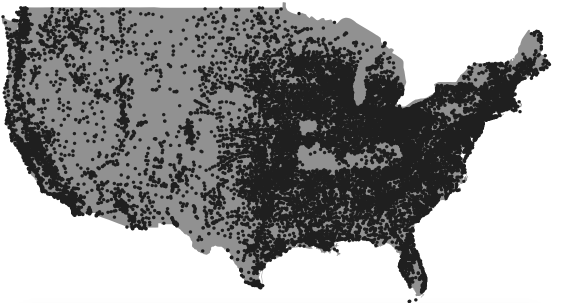
Table 3. Run times for the partial schools dataset